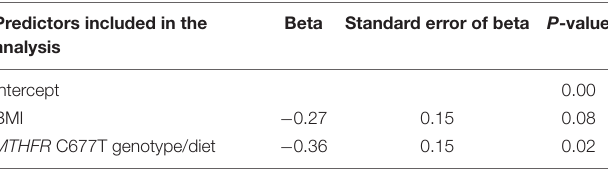
TABLE 5 | Multivariate analysis of predictors that influence LINE-1 methylation in mothers of children with DS with septal defects. Predictors included in the Beta Standard error of beta P analysis